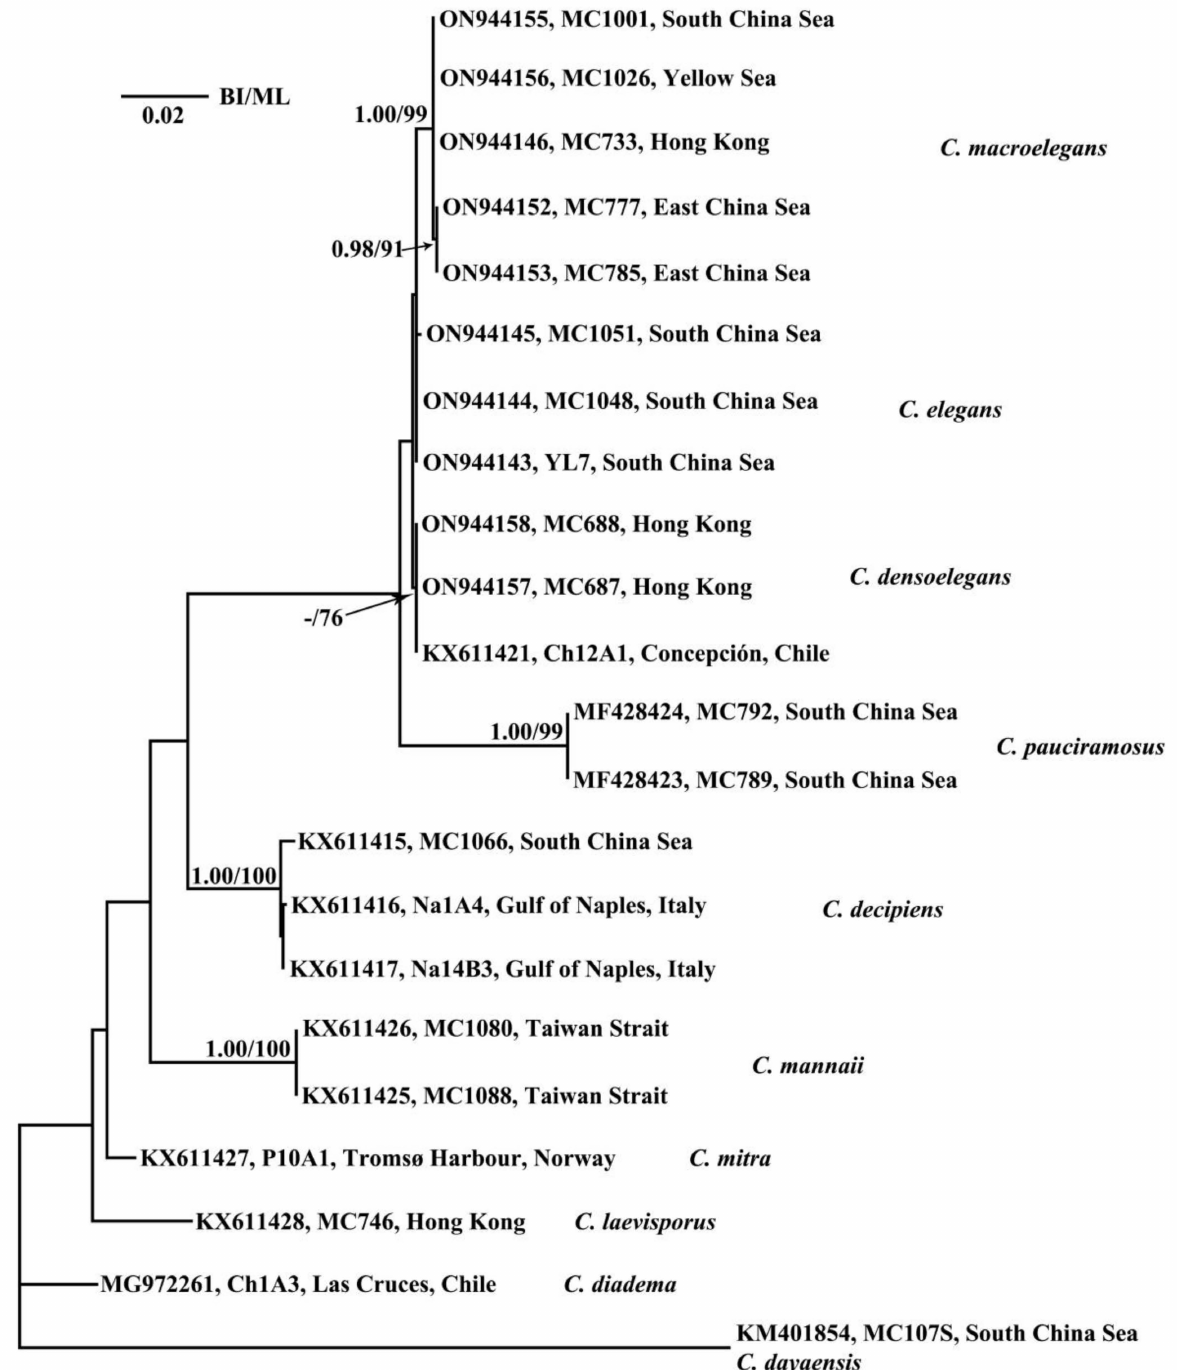
Figure 7. Phylogenetic tree based on maximum likelihood analyses of the SSU rDNA sequences. Only bootstrap support from Bayesian analyses (MrB) ≥ 0.95 and maximum likelihood (ML) ≥ 70% are